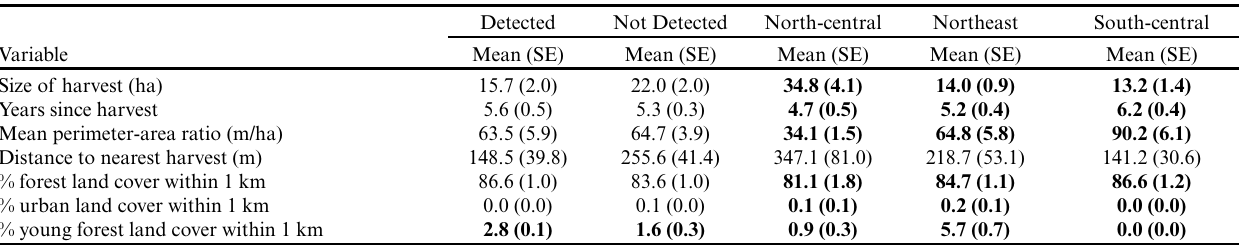
Table 1 . Comparison of stand metrics at regenerating stands where Golden-winged Warblers ( Vermivora chrysoptera ) were (n = 50) and were not (n = 172) detected across the region and in each study region: north-central Pennsylvania (n = 74), northeast Pennsylvania (n = 62), and south-central (n = 86; 2010-2011) regions. Bold text indicates stand features that differed significantly (P < 0.05) in post hoc univariate tests. Detected Not Detected North-central Northeast South-central Variable Mean (SE) Mean (SE) Mean (SE) Mean (SE) Mean (SE) Size of harvest (ha)